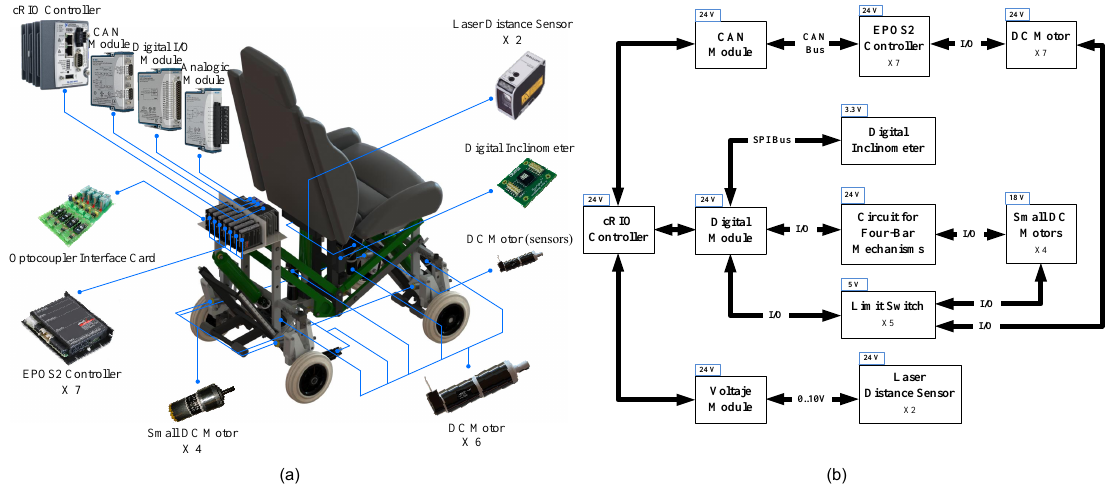
Figure 17. ( a ) Physical and ( b ) functional perspective of the hardware control